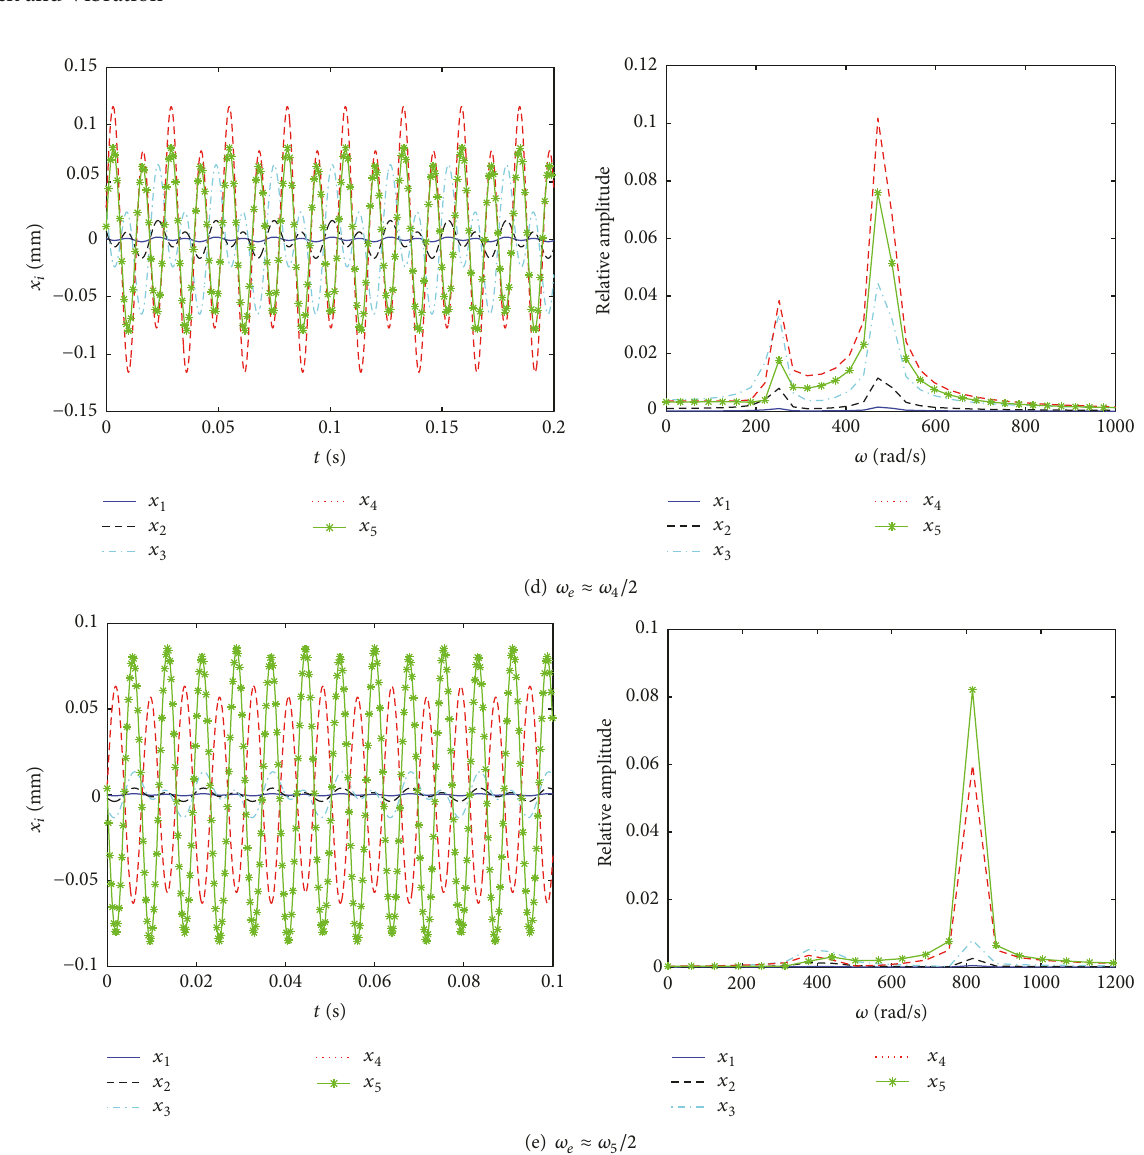
Figure 7: Main resonance when 𝜔 𝑒 ≈ 𝜔 𝑖 /2